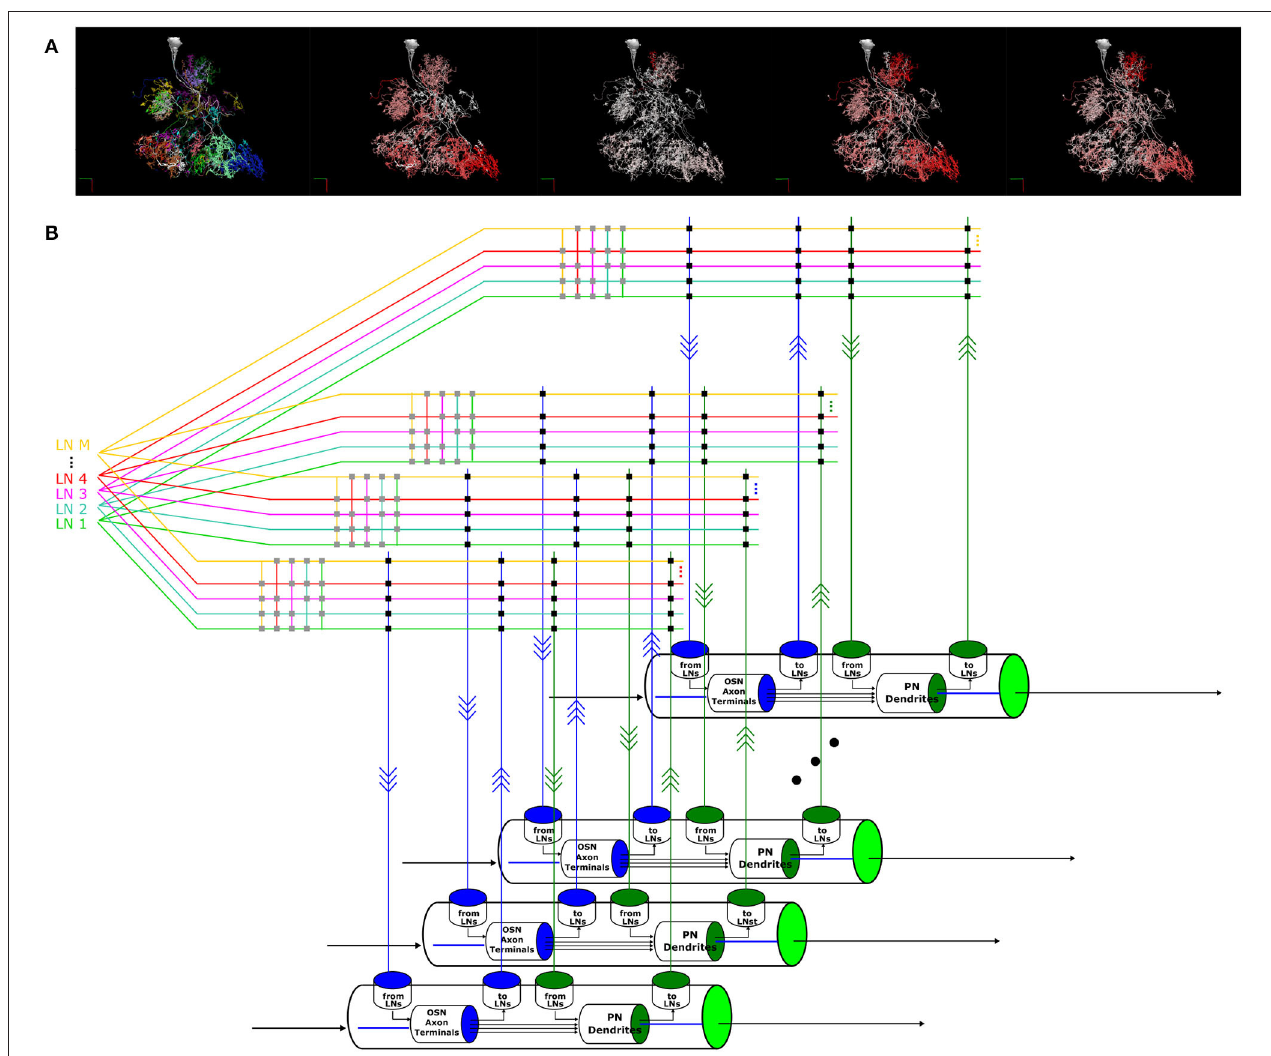
FIGURE 11 | A circuit diagram modeling the entire AL circuit. (A) Morphology of an LN, its innervation of glomeruli and its connectivity to the glomeruli it innervates. The neurites in each glomerulus are colored differently, and from left to right: 1) Each color indicates the glomerulus the LN arborizes. 2) The arbors of the LN in each glomerulus are colored in red with saturation proportional to the number of synapses with the OSNs with axons arborizing in that glomerulus, i.e., redder indicates higher number of synapses. 3) The arbors of the LN in each glomerulus are colored in red with saturation proportional to the number of synapses onto the OSNs with axons arborizing in that glomerulus. 4) The arbors of the LN in each glomerulus are colored in red with saturation proportional to the number of synapses with the PNs in that glomerulus. 5) The arbors of the LN in each glomerulus is colored in red with saturation proportional to the number of synapses onto the uPNs in that glomerulus. (B) Schematic diagram of the glomeruli and the massive number of feedback circuits in the AL.